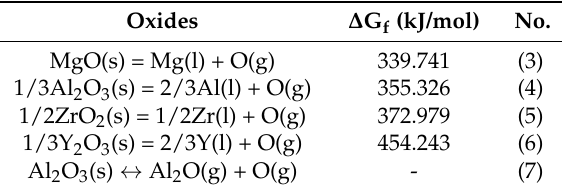
Table 4. Gibbs free energy of formation of the metallic oxides at 1900